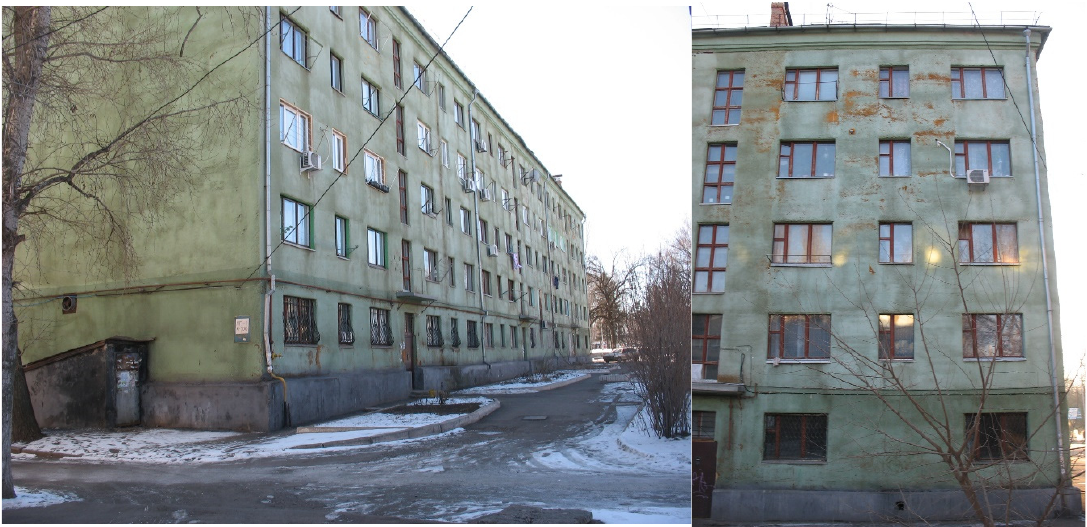
Figure 2. External view of the 5 ‐ storey building under investigation.